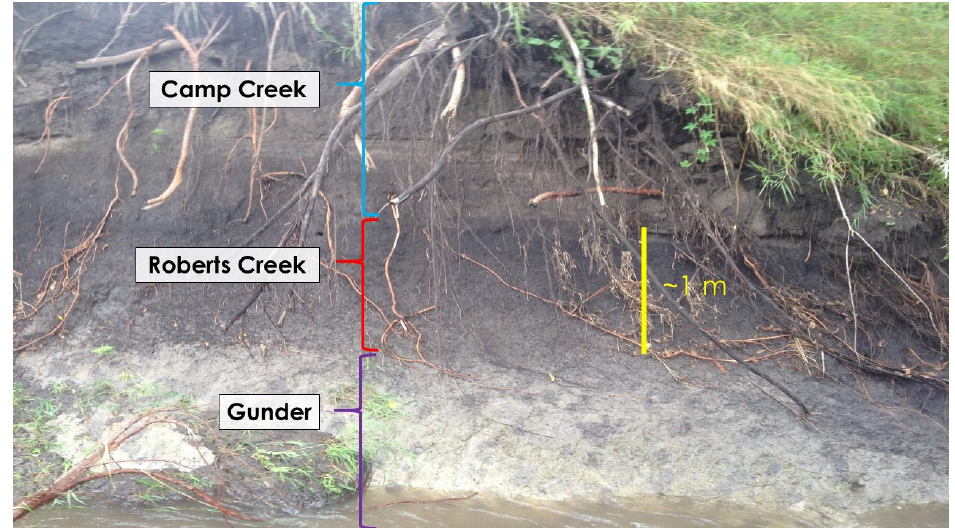
Figure 3. Photograph depicting stratigraphic position and scale of streambank alluvial units, Walnut Creek, Iowa. Photo credit: Hanna McBrearty, Iowa State University.